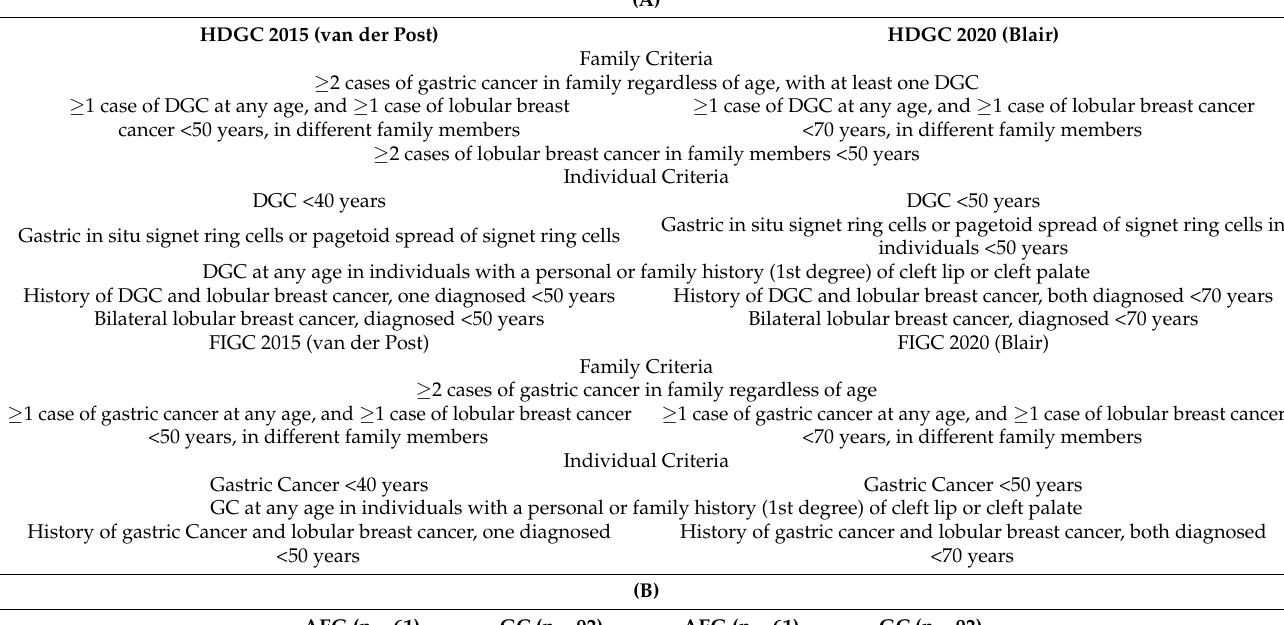
Table 2. ( A ) Comparison of criteria from 2015 (van der Post 2015) with the 2020 updated criteria (Blair 2020). Criteria were also applied for patients with intestinal type carcinoma (AEG: adenocarcinoma of the esophageal–gastric junction; DGC: diffuse-type gastric cancer; FIGC: familial intestinal gastric cancer; HDGC: hereditary diffuse gastric cancer). ( B ) Impact to patient data according to changed criteria from 2015 (van der Post 2015) with the 2020 updated criteria (Blair 2020). Criteria were also applied for patients with intestinal-type carcinoma (FIGC); ()* inclusive unknown histology. Criteria not fulfilled by at least one patient in our cohort are not displayed in this Table (AEG: adenocarcinoma of the esophageal–gastric junction; DGC: diffuse-type gastric cancer; FIGC: familial intestinal gastric cancer; HDGC: hereditary diffuse gastric